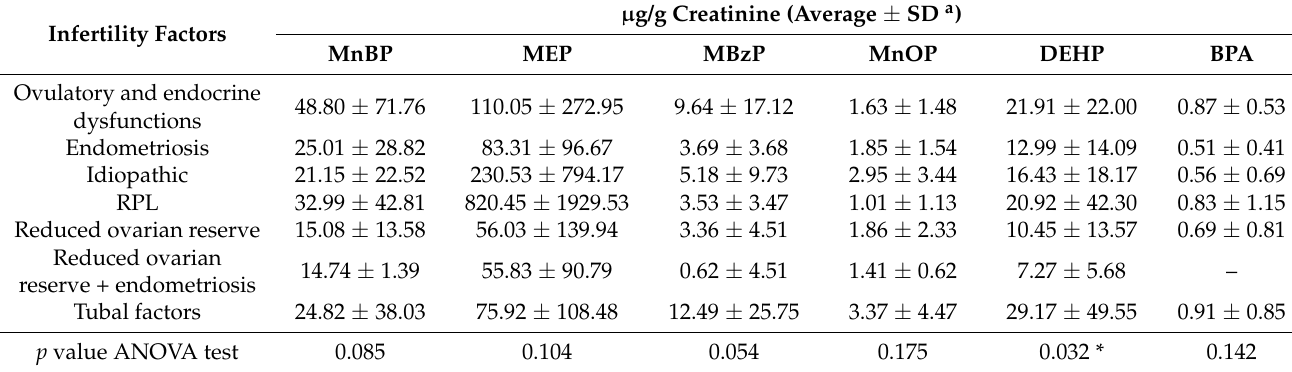
Table 6. Data stratification for infertility factors–female sample ( n =